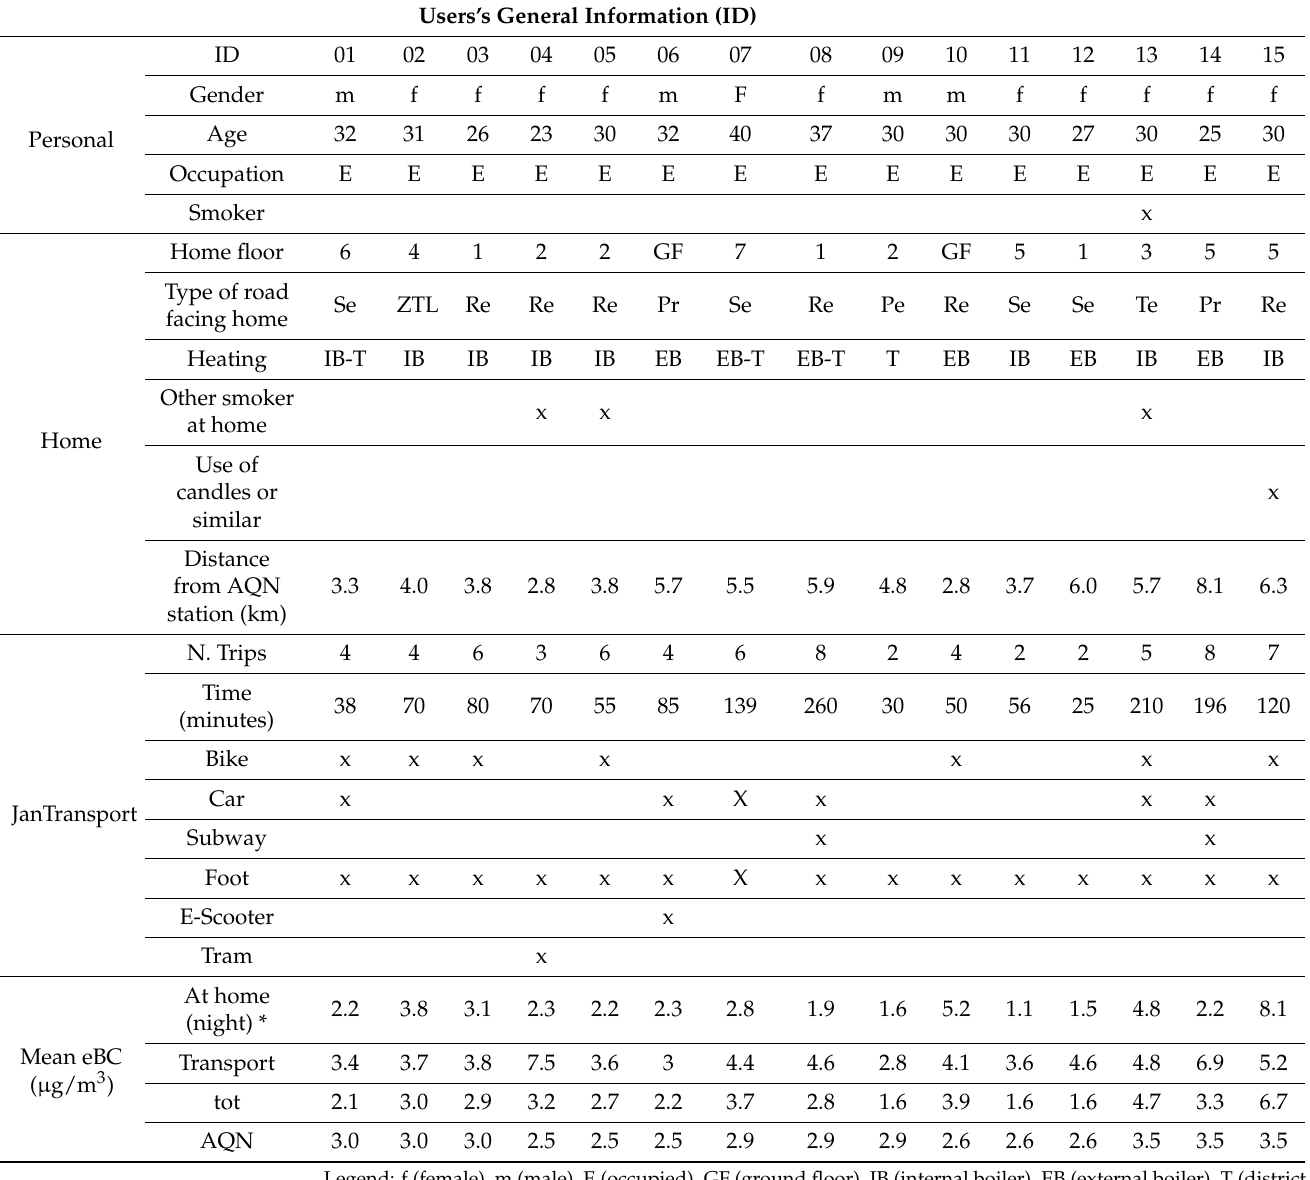
Table 1. Users’ general information